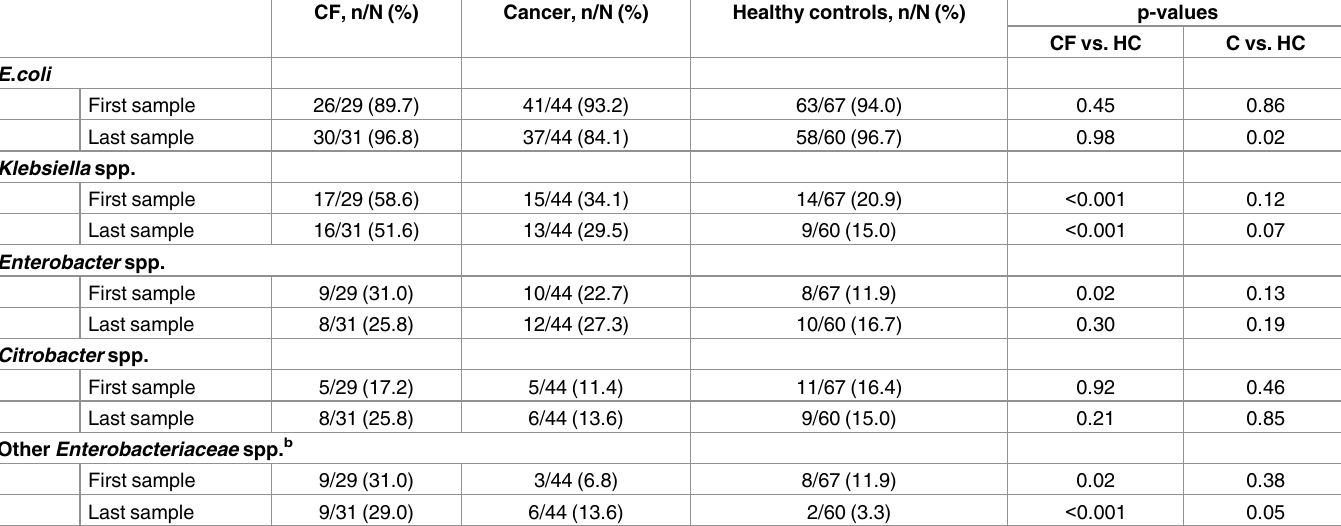
Table 2. Growth of different Enterobacteriaceae species in faecal samples from 32 children with cystic fibrosis, 45 children with cancer and 70 healthy children a . CF, n/N (%)